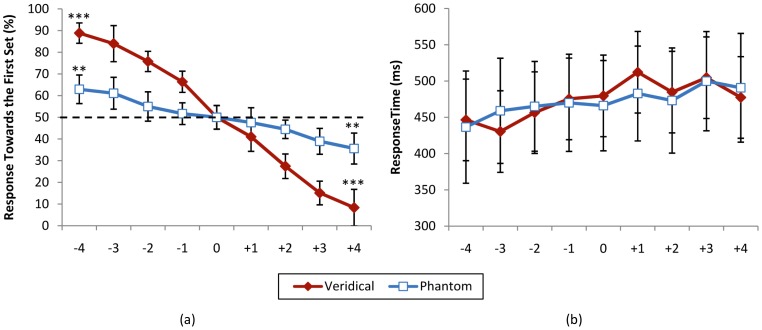
Psychometric function for the numerosity judgement task.(a) Percentage response towards the first set and (b) response time for veridical (n1≠n2, t1 = t2) and phantom (n1 = n2, t1≠t2) conditions. Horizontal axis shows different levels of comparison (n2−n1 for veridical and t2−t1 for phantom trials). *** p<0.001, ** p<0.005. Error bars reflect one standard deviation.